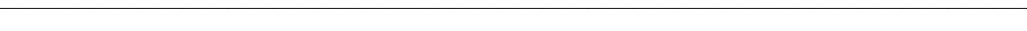
Fig. 5. Changes in the extent of Lake Pielinen. A , the maximum post-glacial extent of the Sotkamo(cid:150)Pielinen ice-dammed lake in the Pielinen basin before the drainage of the ice-dammed lake roughly at 11 300 cal yr BP. The present extent of the lake is shown with dark blue. The outlet channel of the ice-dammed lake in its southeastern part in Uimaharju and an older outlet channel in Porttikallio are shown with an arrow. B , Lake Pielinen after 11 300 cal yr BP after the drainage of the ice-dammed lake. The present shoreline is marked at the southern part of the lake. The outlet channel was in Kallioj(cid:228)rvi in the northwestern part of the lake. C , the maximum extent of the early Holocene Lake Pielinen at 10 200 cal yr BP. The lake is bifurcative with an outlet channel in the northwest and in the southeast. The present extent of the lake is shown. D , Lake Pielinen after all glacial isostatic adjustment has taken place, estimated to happen by 10 000 years after present. The present shoreline is shown with a black